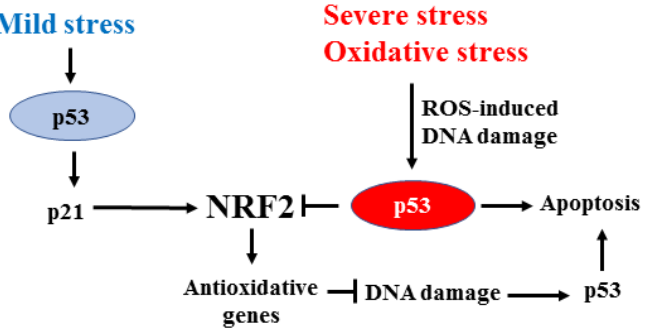
Figure 4. Interplay between p53 and NRF2. In response to mild stress, wtp53 is activated to mainly induce p21 (instead of apoptotic genes) that contributes to NRF2 stabilization. The antioxidant function of NRF2 protects cells from the DNA damage that usually triggers p53 apoptotic activation. Severe oxidative stress, with elevated ROS levels, activates wtp53 apoptotic function and represses the transcription of NRF2 target genes. The mild/severe stress balances the final NRF2/p53 dependent cell survival/death decision in a regulatory feedback